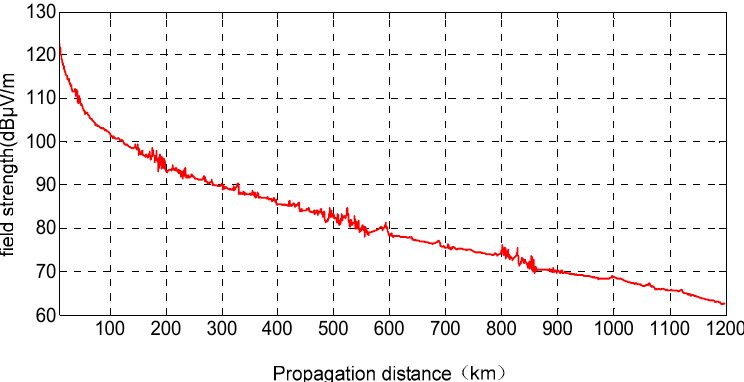
Figure 18. Field intensity propagation curve of the transmitted signal from the northward-oriented antenna.